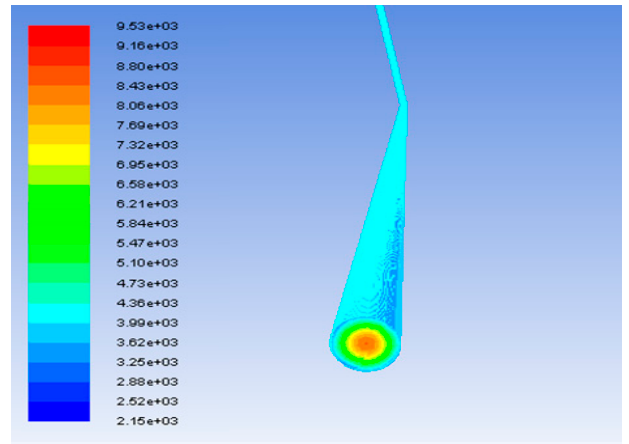
Figure 5. Contour of dynamic pressure.